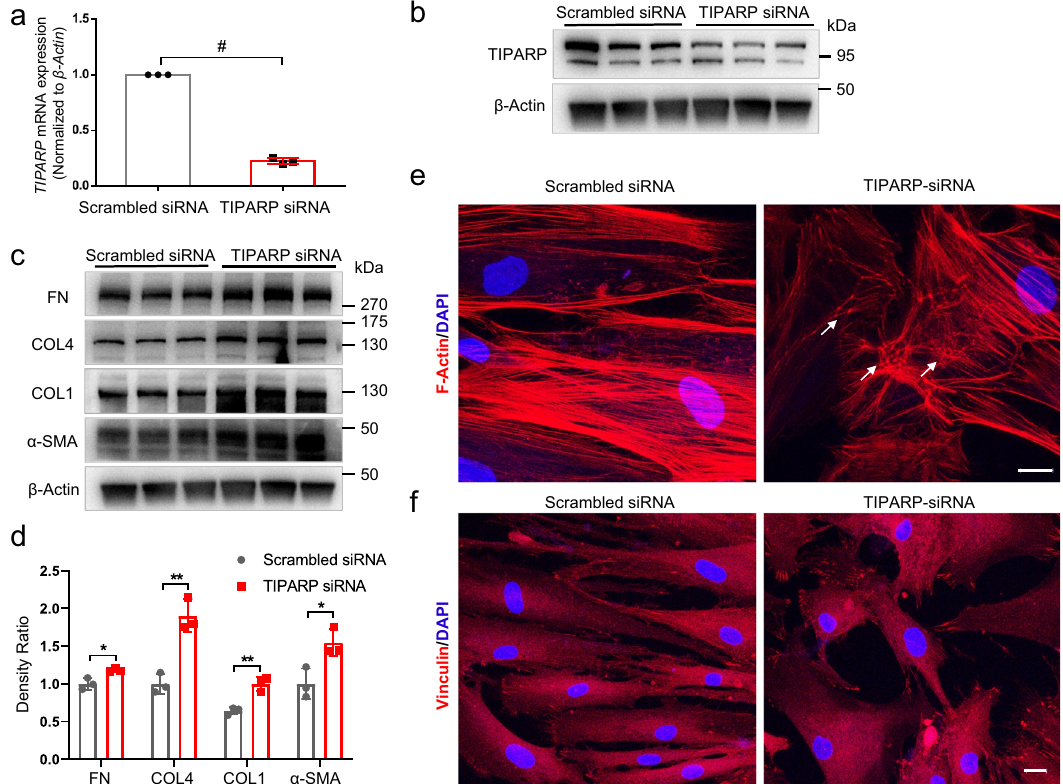
Fig. 6 Suppression of TIPARP expression by siRNA transfection activated the formation of CLAN, focal adhesion, and ECM deposition in HTM cells. HTM cells were transfected with TIPARP siRNA or scramble siRNA. a qRT ‒ PCR showed that TIPARP siRNA transfection decreased TIPARP expression by 0.22-fold compared with scrambled siRNA transfected controls ( n = 3, t test). b Western blot con fi rmed that the expression of TIPARP protein was downregulated in the TIPARP siRNA-treated HTM cells compared with the scramble siRNA-treated HTM cells. c , d Western blot and quantitative analyses showed that the expression of fi bronectin, collagen type IV, collagen type I and α -SMA increased in the TIPARP siRNA-treated HTM cells compared with the scrambled control cells ( n = 3, t test). e The HTM cells treated with TIPARP siRNA showed increased formation of CLAN (white arrows) by phalloidin staining compared to the scrambled siRNA-treated control cells. f The HTM cells treated with TIPARP siRNA exhibited an increase in the focal adhesion marker vinculin by immuno fl uorescence compared to the control cells. Data are presented as the means ± standard deviations. * P < 0.05, ** P < 0.01, # P < 0.0001. Scale bar = 20 μ m. CLAN cross-linked actin network, COL1 collagen type I, COL4 collagen type IV, FN fi